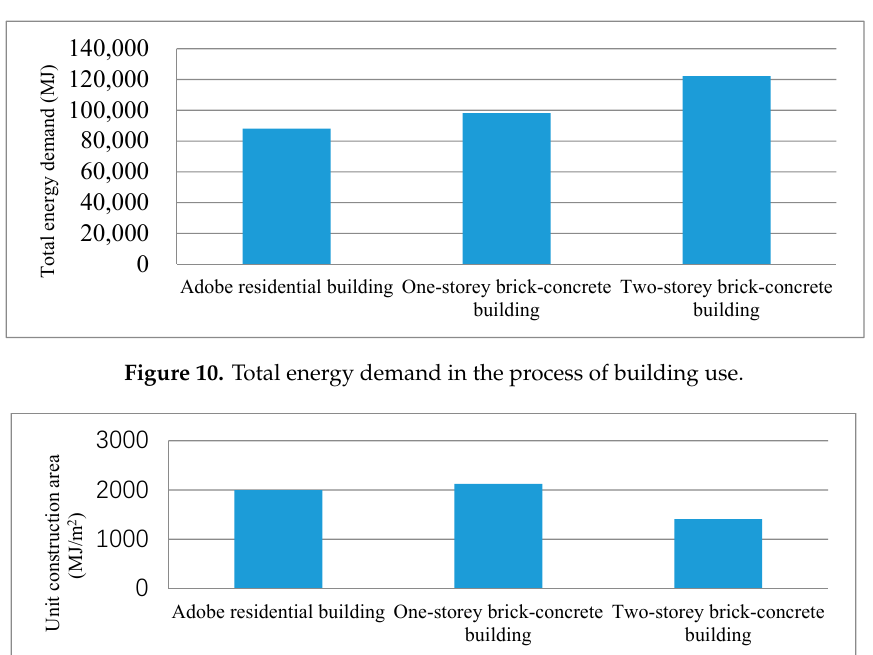
Figure 9. Energy demand of building erection in unit construction area (MJ).